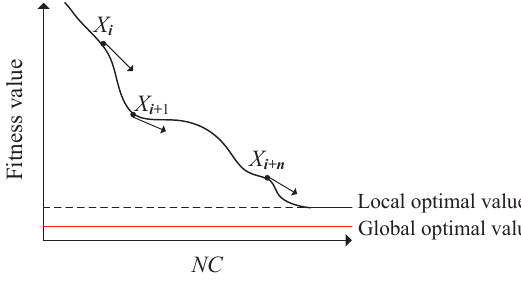
Figure 7. Model diagram of the Cauchy